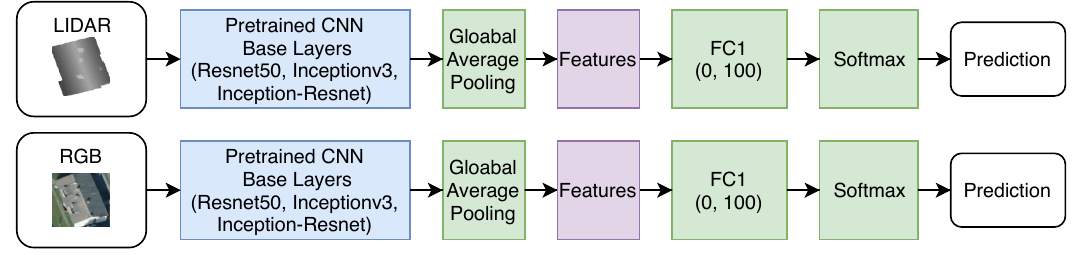
Figure 6. CNN architecture templates.